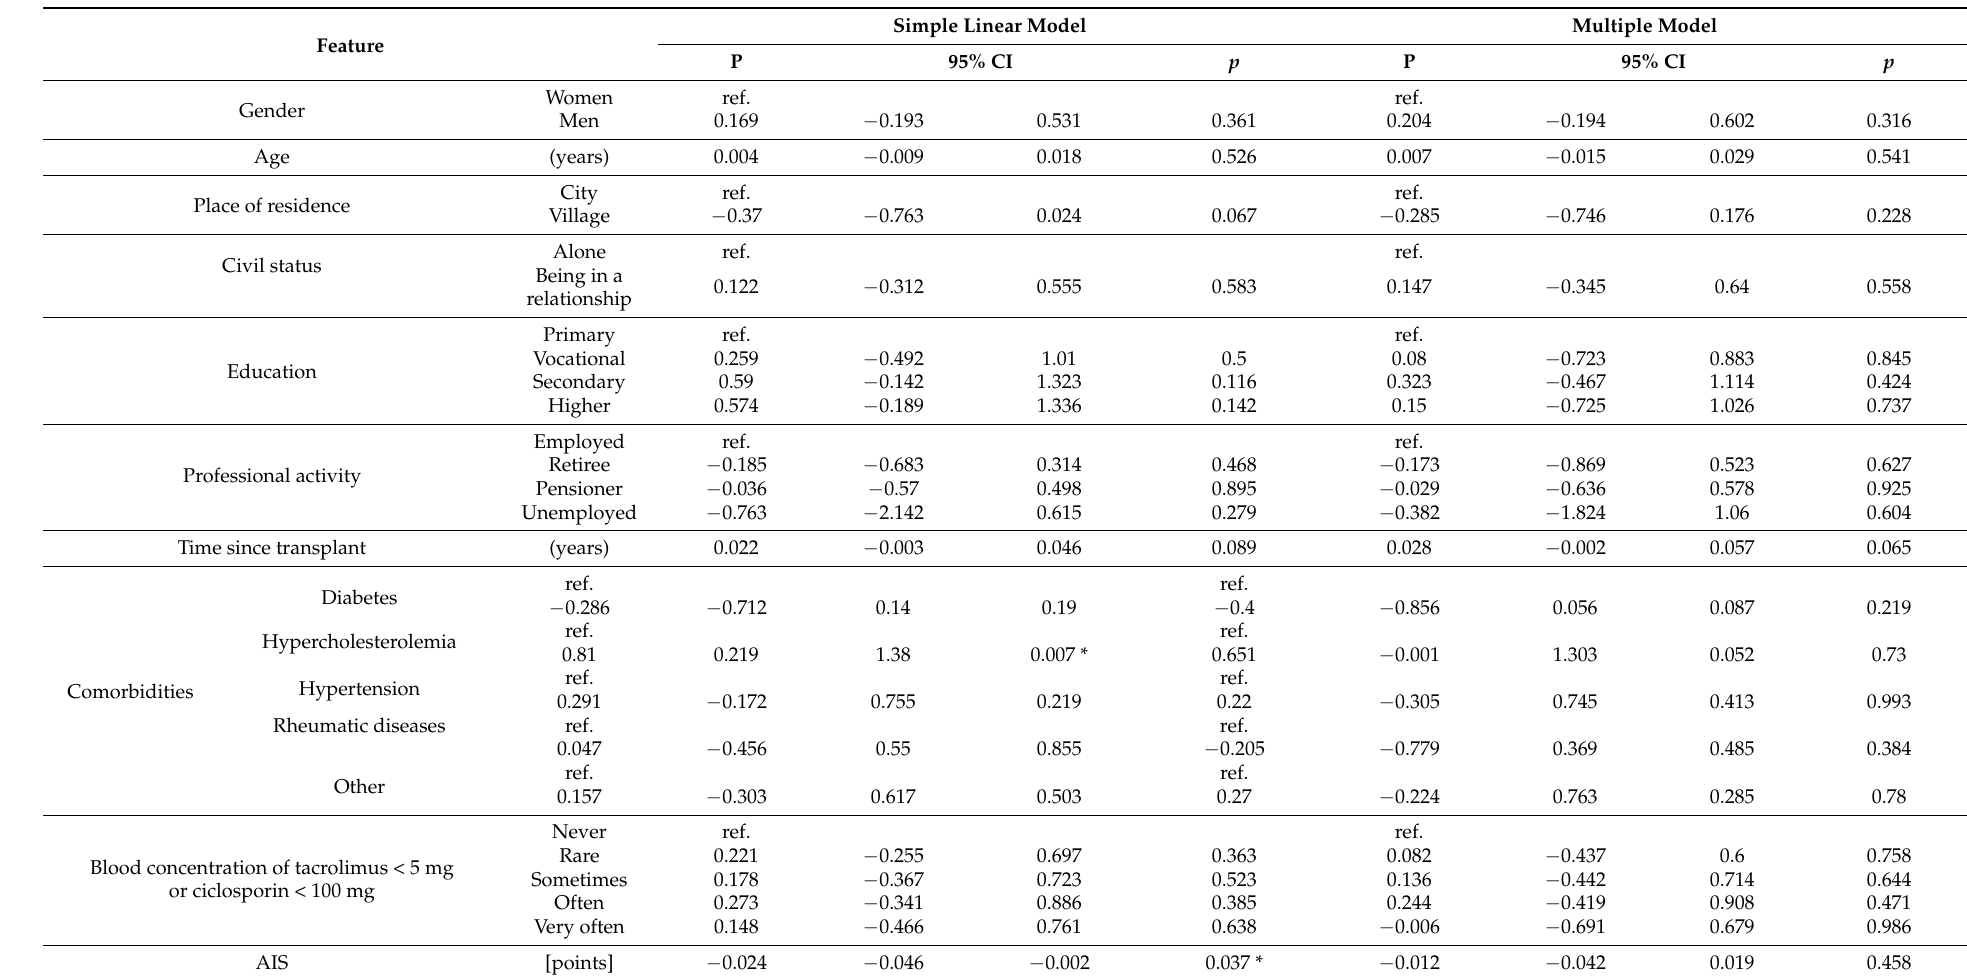
Table 4. ARMS taking medications subscale: simple linear regression and multiple regression